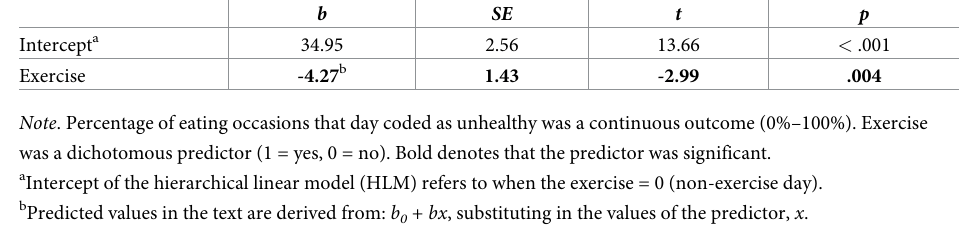
There were five significant individual predictors: Participants were relatively more likely to eat unhealthily when they were not hungry (predicted odds = 1.04) compared to when they were hungry (predicted odds = 0.47). Participants were also relatively more likely to eat unhealthily when they were in a bad mood (predicted odds = 2.34) than when they were not in a bad mood (predicted odds = 0.52). Unplanned meals were relatively more likely to be unhealthy (predicted odds = 1.10) than were planned meals (predicted odds = 0.29), and par- ticipants were also more likely to choose unhealthy options at post-exercise meals when they had to go out of their way to obtain the food (predicted odds = 0.98) compared to when it was readily available (predicted odds = 0.49). Finally, participants were more likely to eat unhealth- ily after exercise when they were not at home (predicted odds = 0.87) compared to when they were at home (predicted odds = 0.39). There were only two significant predictors of eating healthily (relative to mixed) after exer- cise. Participants were more likely to eat healthily when there were no other food options (pre- dicted odds = 0.74) compared to when other food options were available (predicted odds = 0.38). Post-exercise meals were also more likely to be healthy when participants felt they were not in a rush (predicted odds = 0.75) compared to when they were in a rush (pre- dicted odds = 0.32; see S1 Table in S1 File). All seven of the significant predictors (i.e., both those that predicted eating unhealthily and those that predicted eating healthily) were then entered together into an overall model. Meal planning was the only predictor that remained significant in the overall model for eating